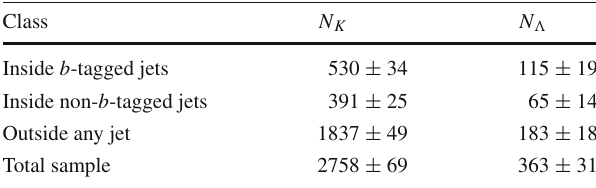
Table 4 The numbers of K 0 and (cid:3) particles ( N K and N (cid:3) ) recon- S structed in the data after sideband background subtraction for each class and for the total sample with their statistical uncertainties Class N K N